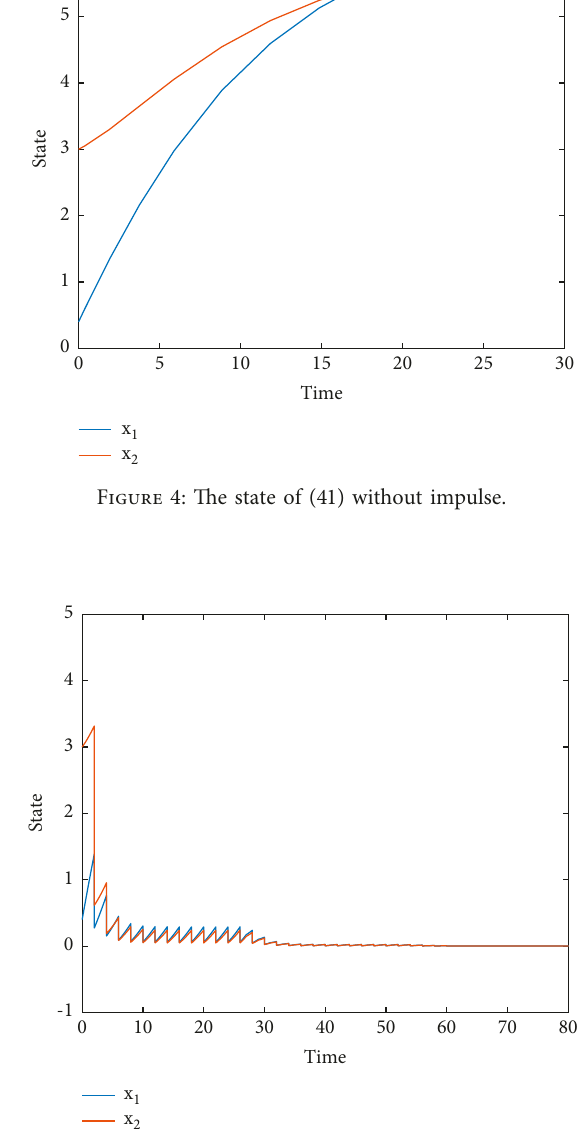
Figure 5: The state of (41) with impulsive effects (42). Table 2: Stability of systems with different time